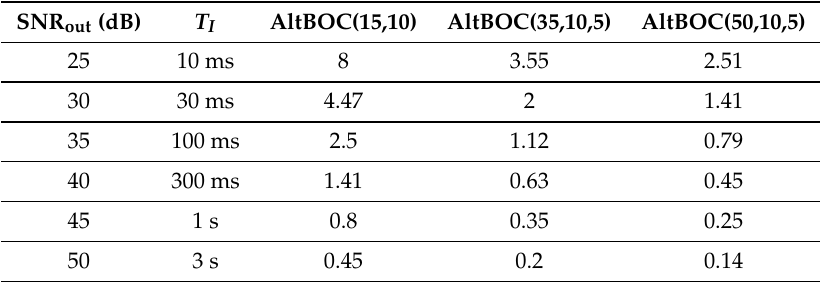
Table 2. Galileo E5 and Meta-signals Time-delay Estimation Standard Deviation (cm). Results for Long Integration Times and C / N 0 = 45